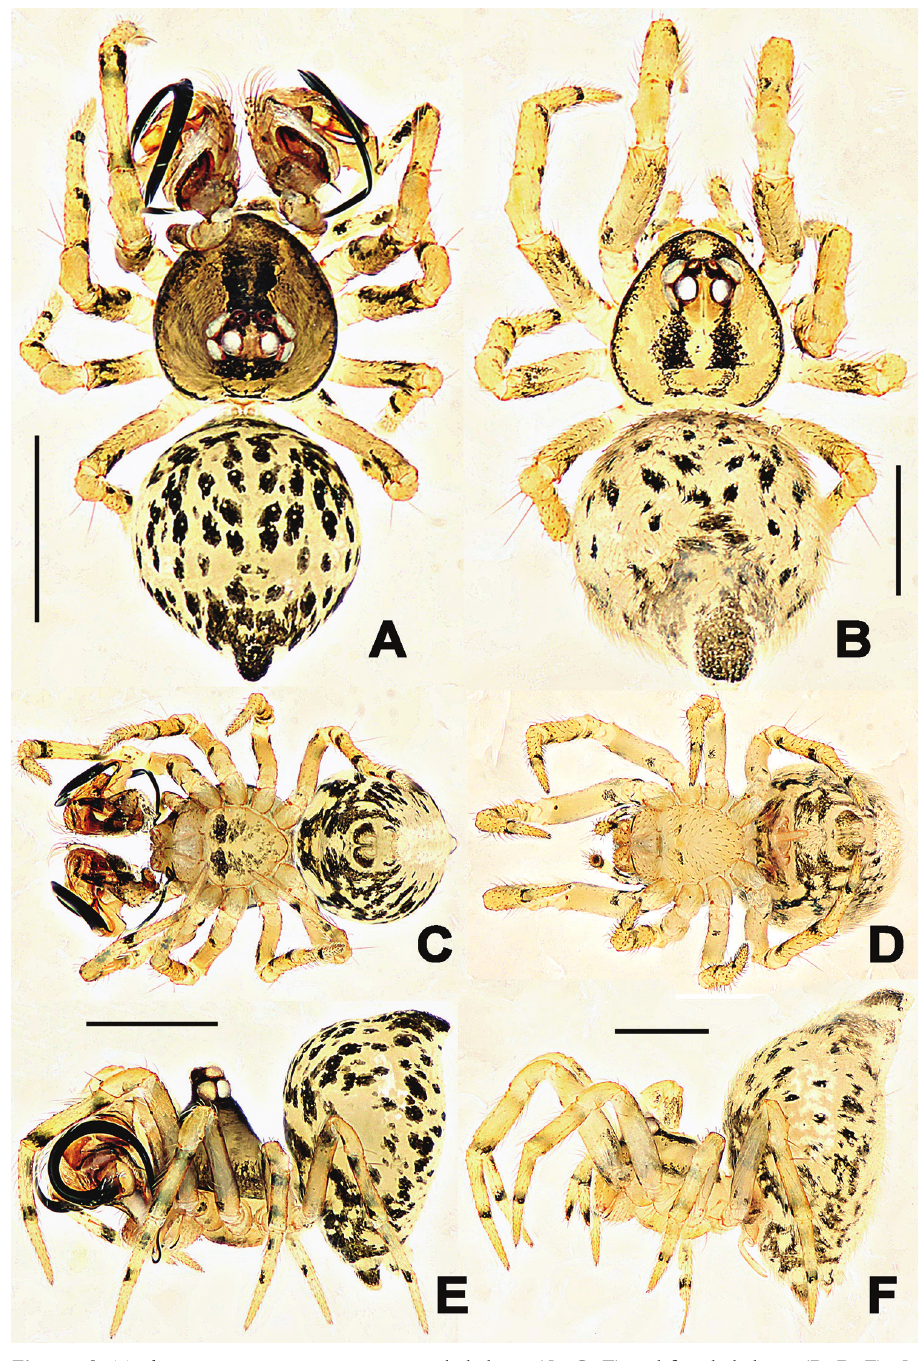
Figure 6. Trogloneta yuensis Lin & Li, 2013, male habitus ( A, C, E ) and female habitus ( B, D, F ). A, B dorsal C–D ventral E–F lateral. Scale bars: 0.50